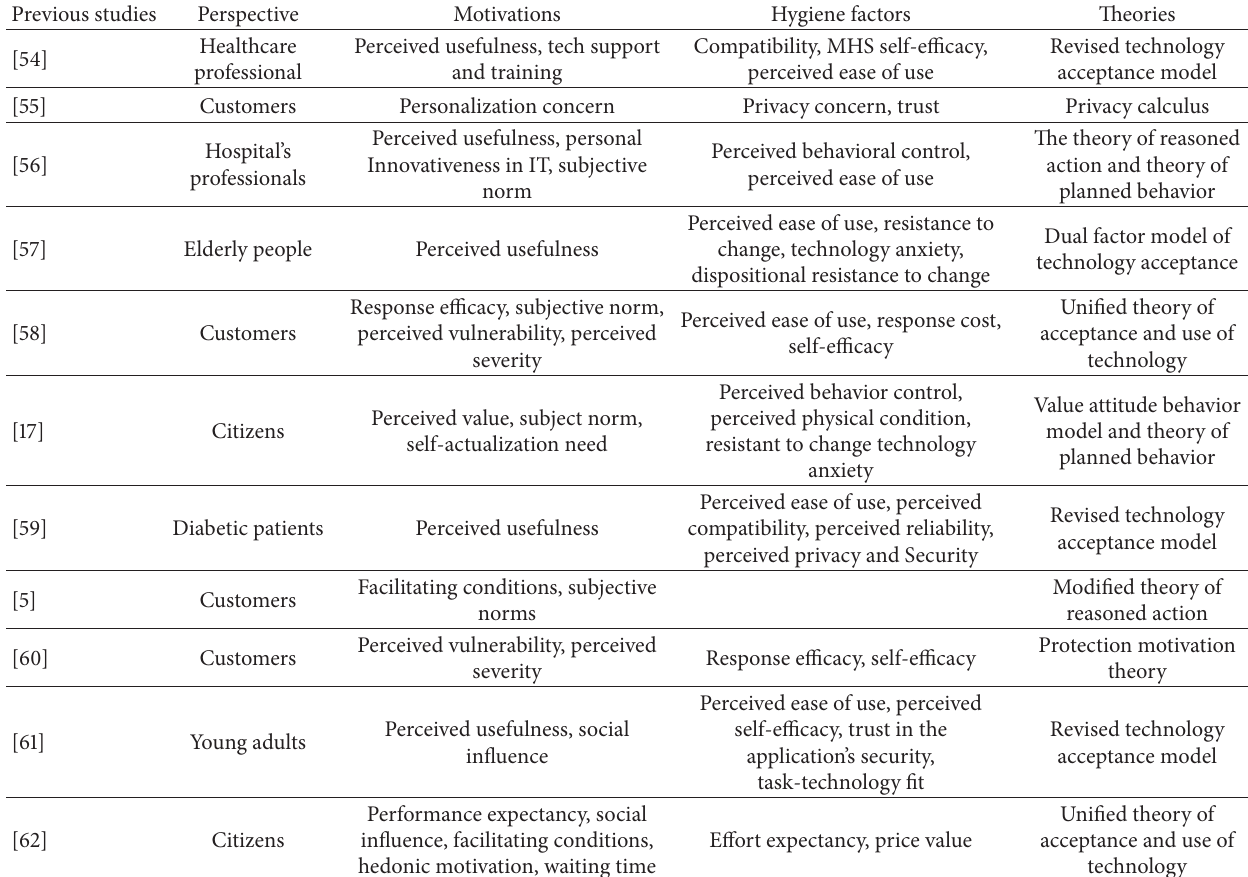
Table 1: Representative sampling of previous studies on MHS